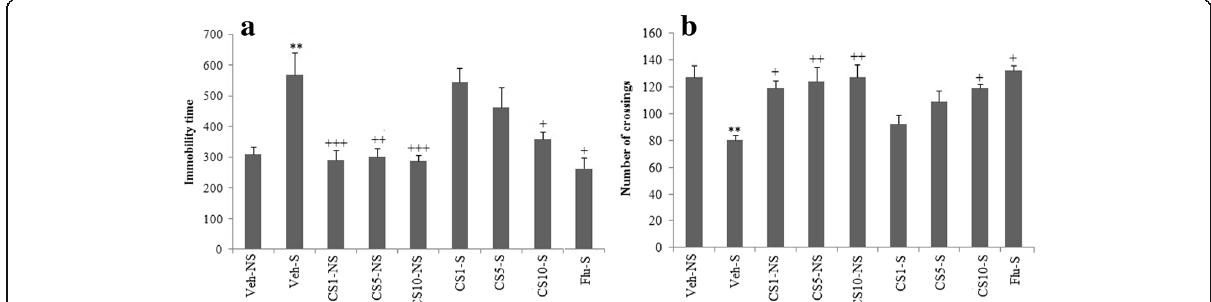
Fig. 1 Effect of the treatment with CS and Flu (positive control) on immobility time in the FST ( a ) and on locomotor activity in the open field test ( b ) in the rat submitted to chronic restraint stress procedure. Each column represents the mean ± SEM ( n = 8). Significantly different from Vthe eh-NS groups (**; P < 0.01). Significantly different from the Veh-S groups (+; P < 0.05, ++; P < 0.01, +++; P < 0.001)